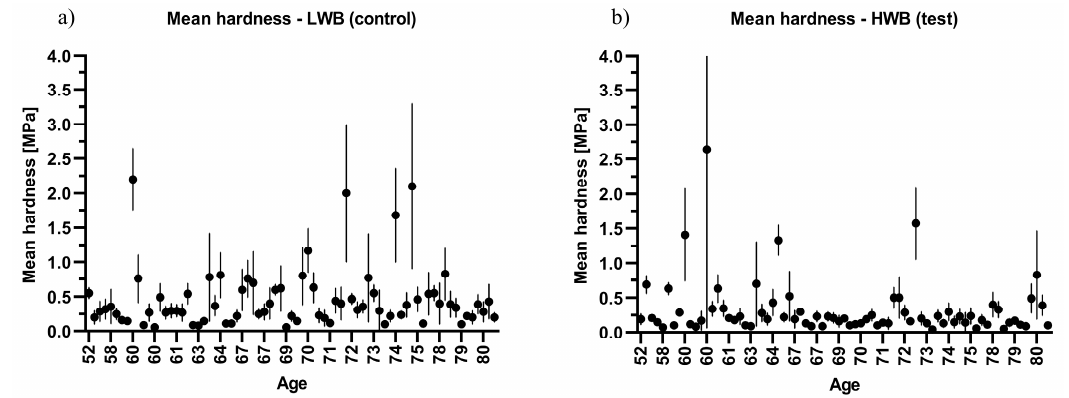
Figure 3. Scatter plot of hardness against age: ( a ) low weight bearing (LWB) sample and ( b ) high weight bearing (HWB) sample.